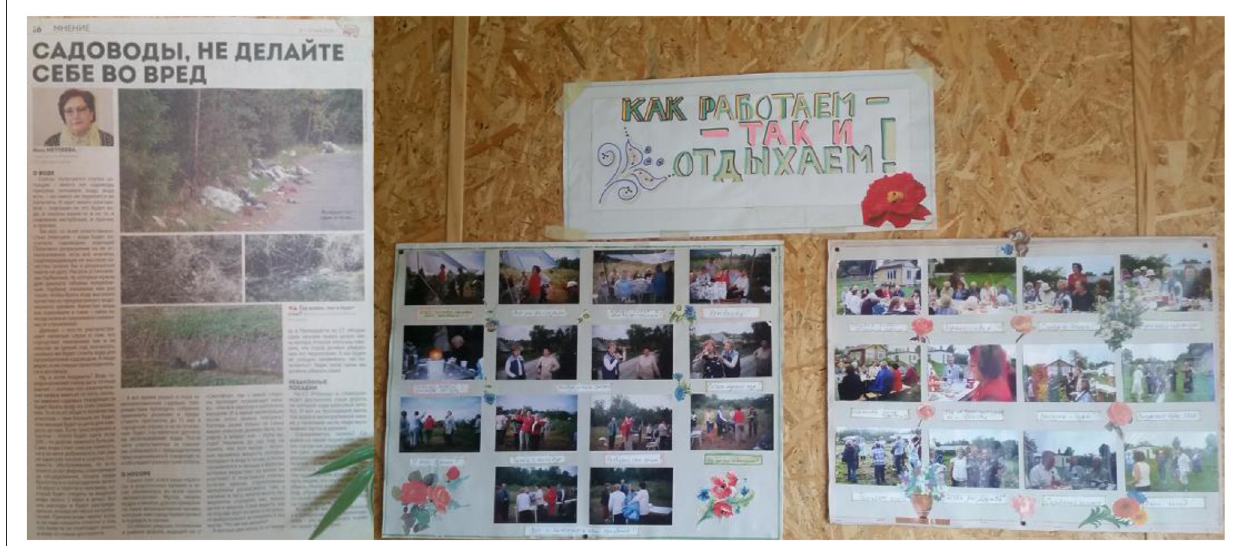
FIGURE4 The photo on the left shows an article written by a chairwoman of a garden cooperative in Kudruküla, near Narva, about environmental hazards (e.g., illegal waste dumping in nearby forests, as seen in the newspaper photo) and environmental consciousness and citizenship. The photo on the right gives a glimpse of the memories of annual midsummer celebrations of the same small cooperative in